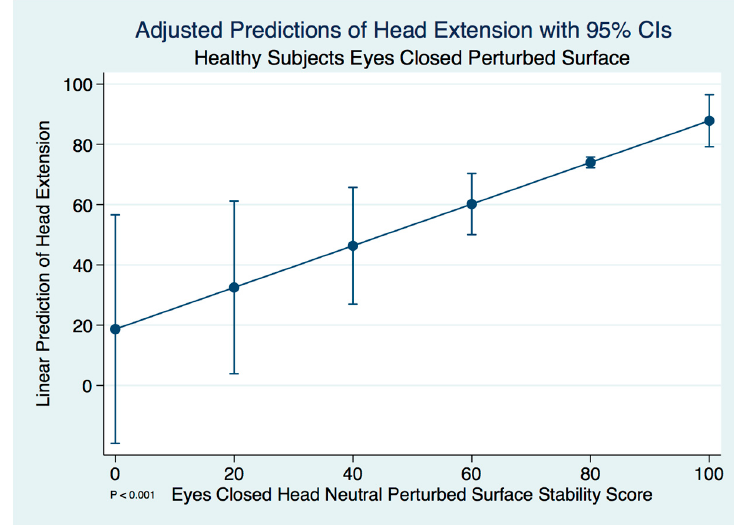
Figure 8. Adjusted predictions of head flexion stability scores in healthy normal controls.